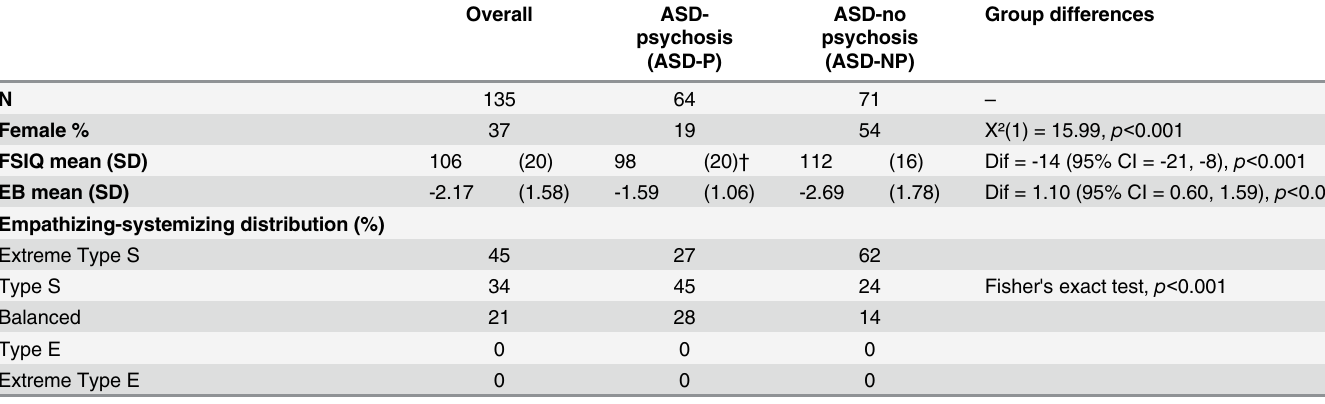
Table 1. Raw differences between ASD-P and ASD-NP groups.